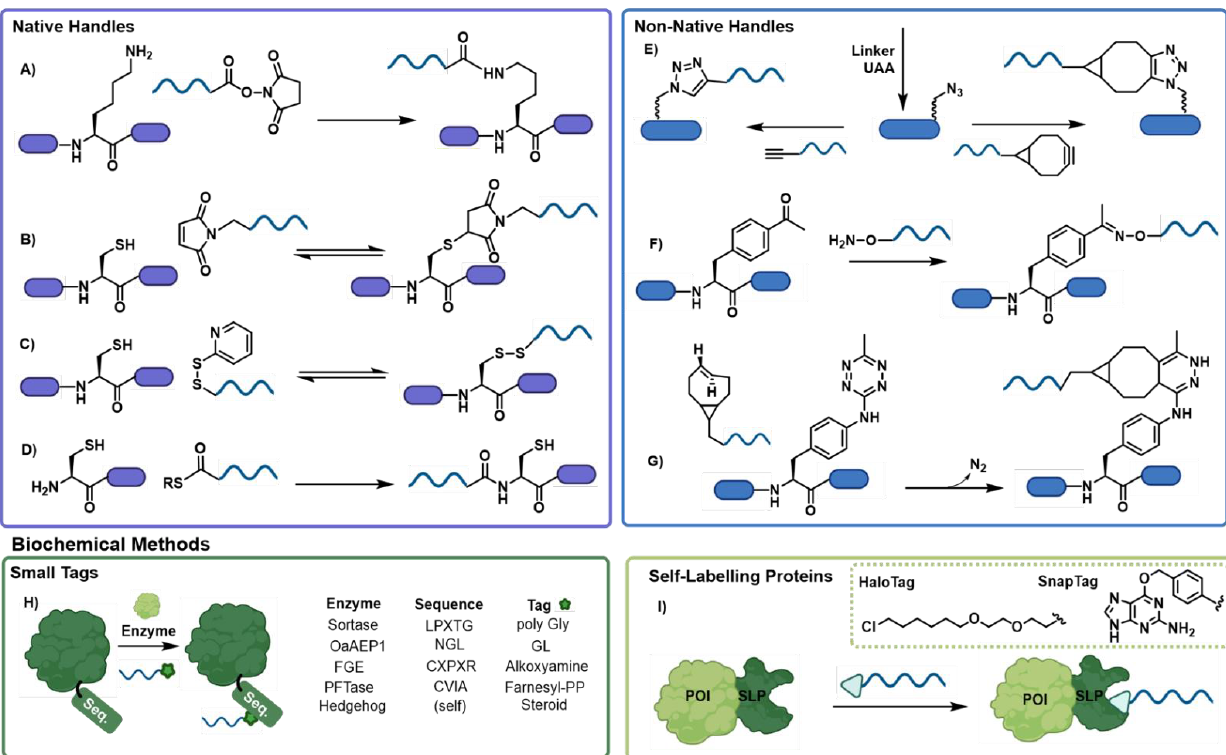
Figure 2. Conjugation chemistries utilized in the formation of protein oligonucleotide conjugates including ( A ) NHS-esters, ( B ) maleimides, ( C ) disulfide bond formation, ( D ) NCL, ( E ) CuAAC and SPAAC, ( F ) oxime ligation, ( G ) tetrazine click, ( H ) enzyme conjugation and ( I ) self-labelling proteins.